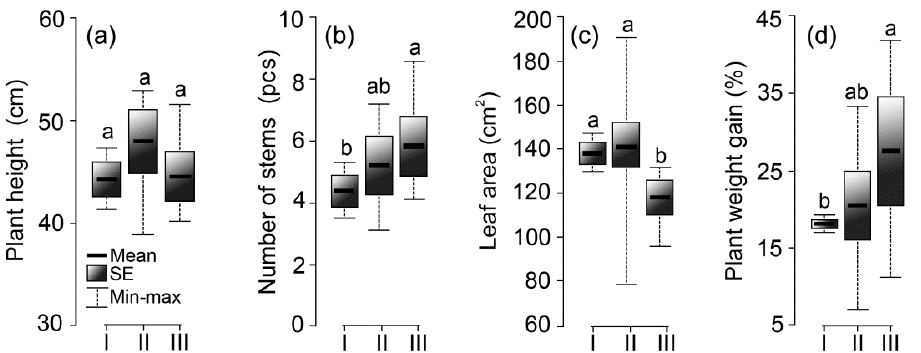
Figure 2. Changes in the plant height ( a ), number of stems ( b ), leaf area ( c ) and plant weight gain ( d ) of potato plants depending on the ripening degree. I—early variety, II—medium-early variety, III—mid-season.